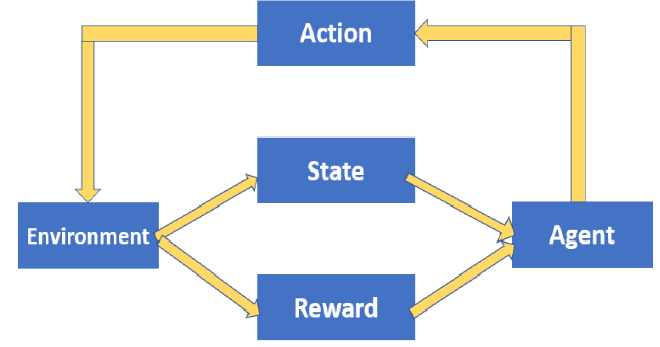
Figure 3. Reinforcement learning working procedure.